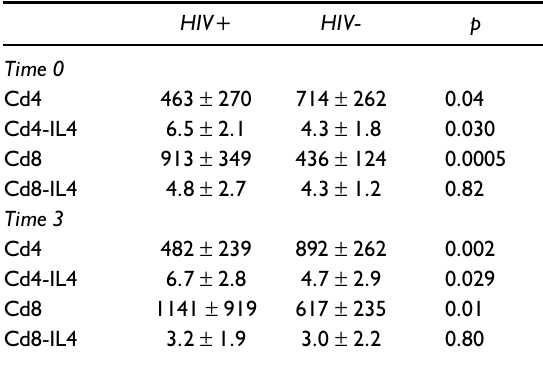
Table 1 Levels of Cd4 and Cd8 cells, and interleukin-4 (IL-4) in